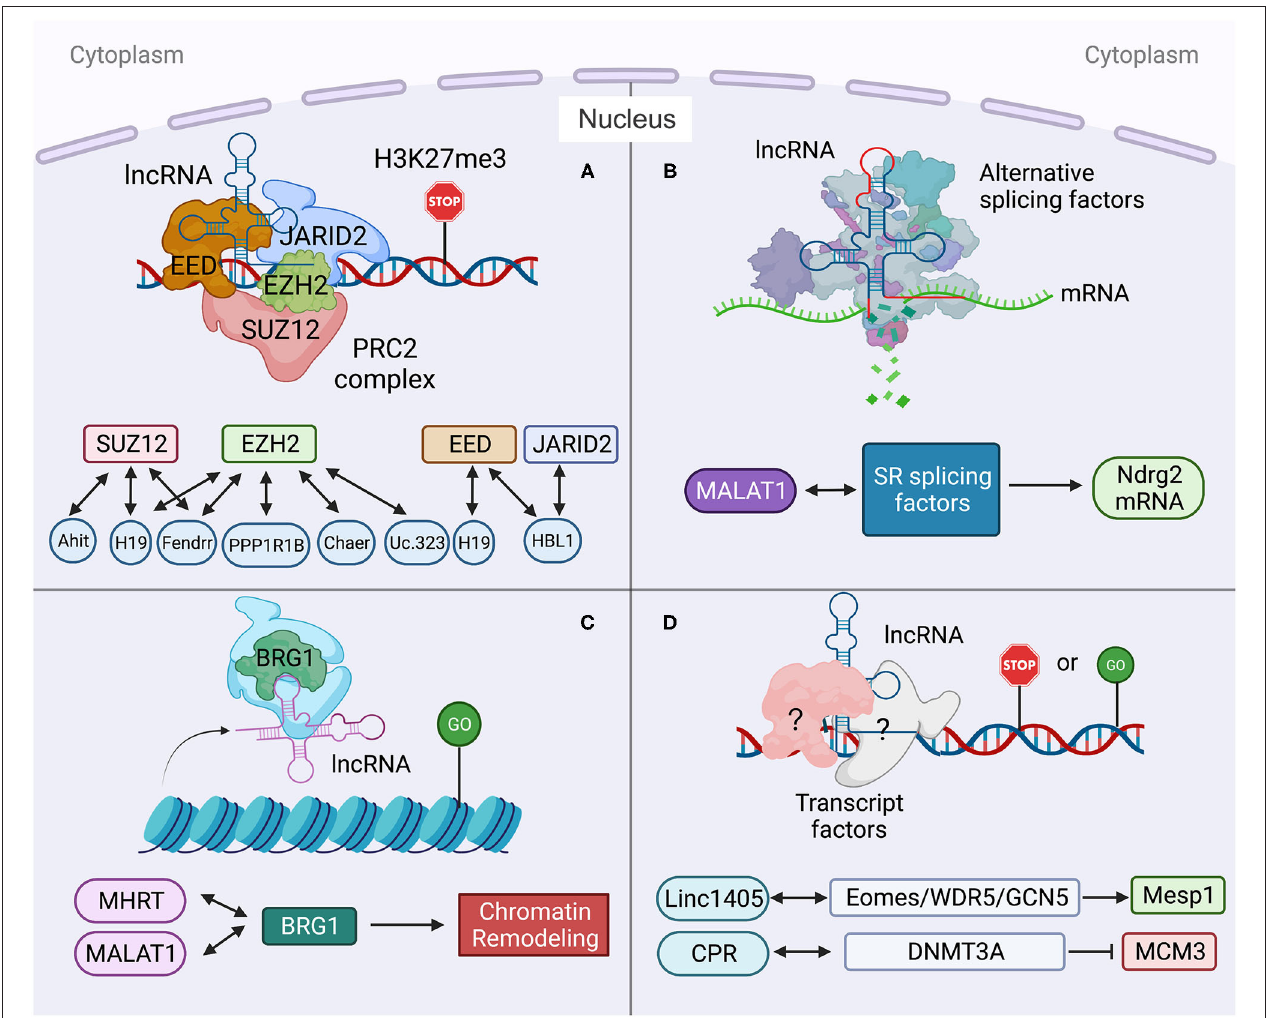
FIGURE 2 | Long non-coding RNA mechanisms in nucleus in heart development and diseases. (A) lncRNA targets to PCR2 complex and regulates its downstream gene transcription. (B) lncRNA regulates pre-mRNA alternative splicing. (C) lncRNA regulates chromatin remodeling. (D) lncRNA interacts with transcription factors to regulate gene transcription. Created with